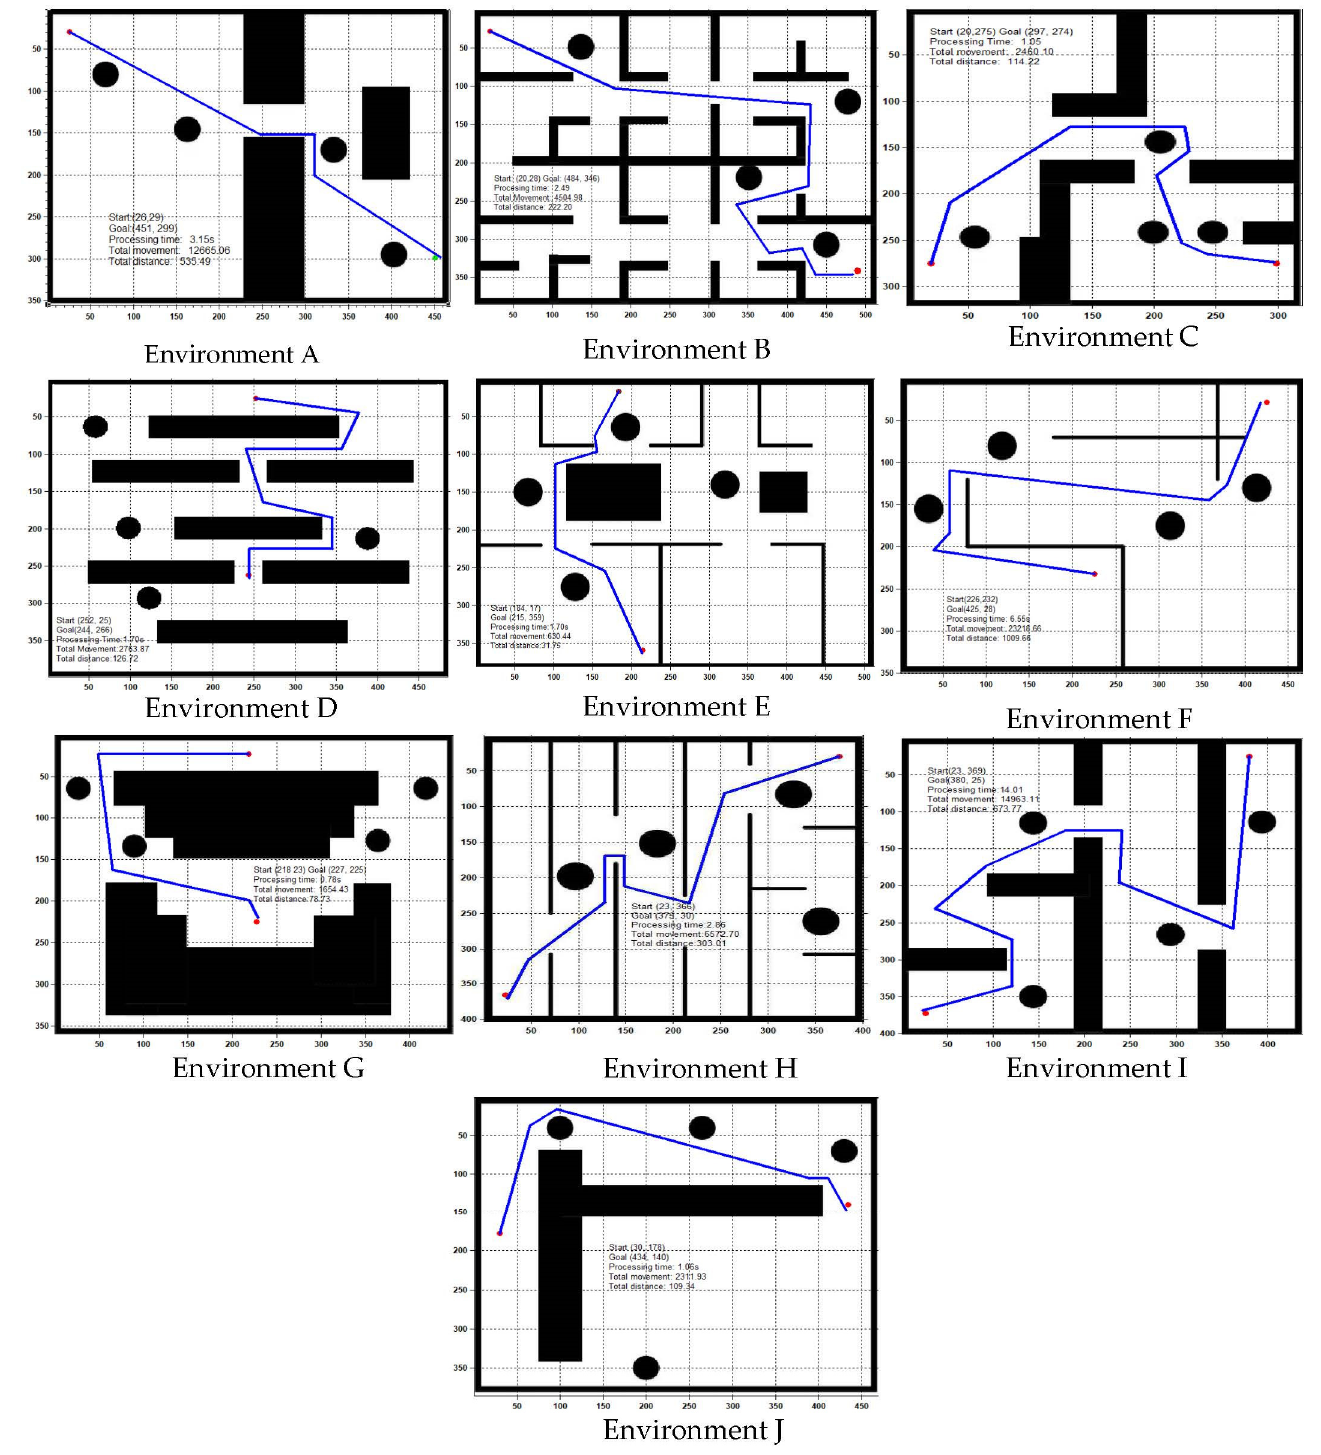
Figure 9. Final path for obstacle avoidance after GLS—second stage (optimization).